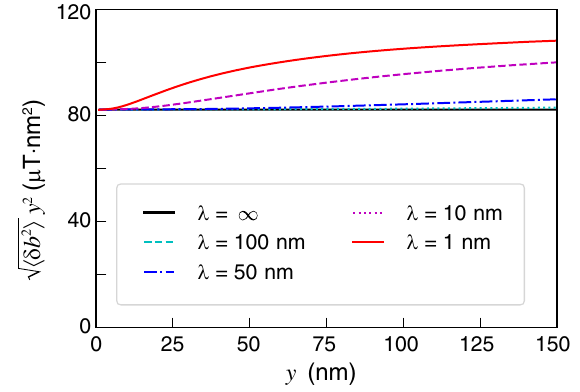
FIG. 11. Calculated Meissner screening of magnetic noise due to the superconducting aluminum for different London penetra- tion depths λ . The magnetic-field standard deviations along the z ffiffiffiffiffiffiffiffiffiffiffi p axis, , are plotted for randomly oriented surface magnetic h δ b 2 i impurities with a uniform density of σ ¼ 10 12 cm − 2 and indi- vidual magnetic moment of μ B ffiffiffiffiffiffiffiffiffiffiffi ( λ → ∞ ), the resulting